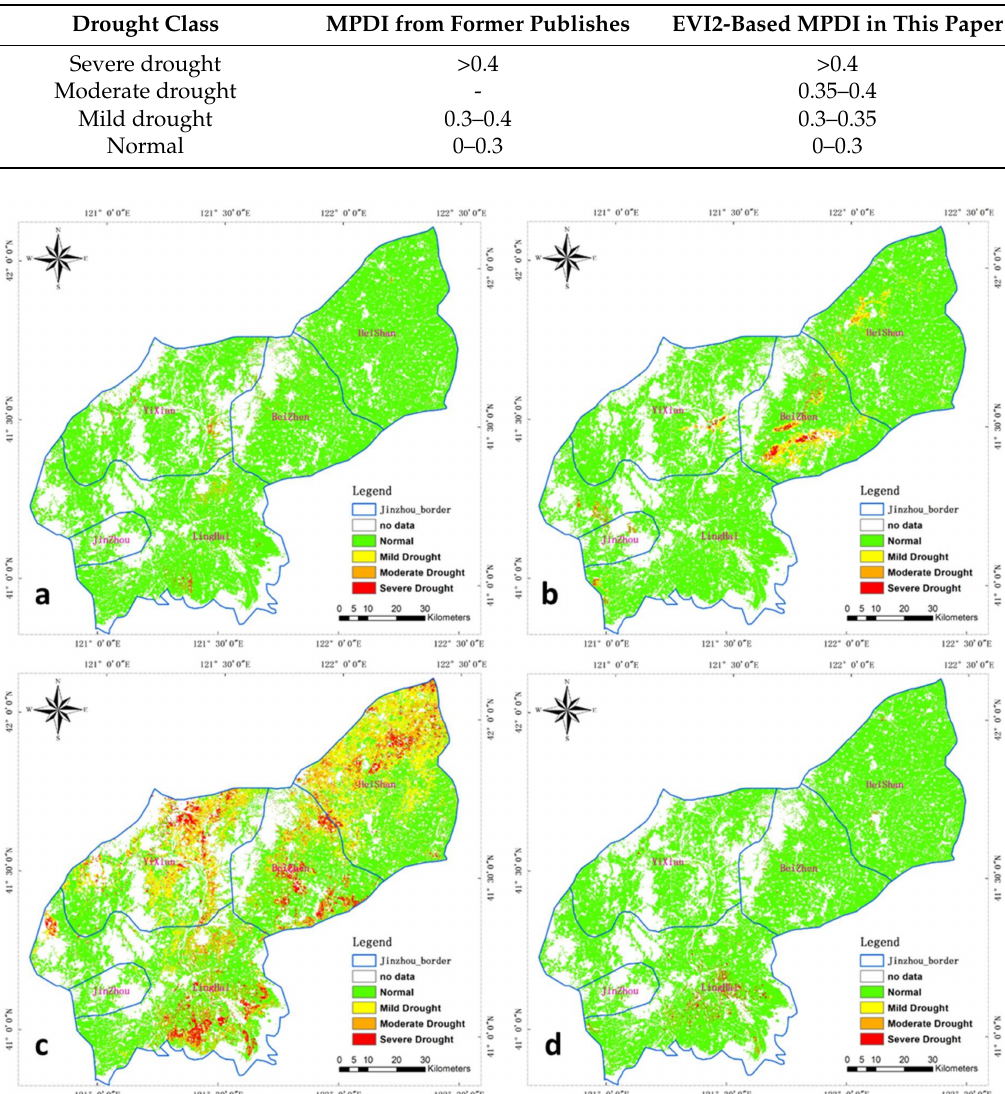
Table 5. Classification of the EVI2-based MPDI and the MPDI from the Ghulam and Qin Qiming drought indices.